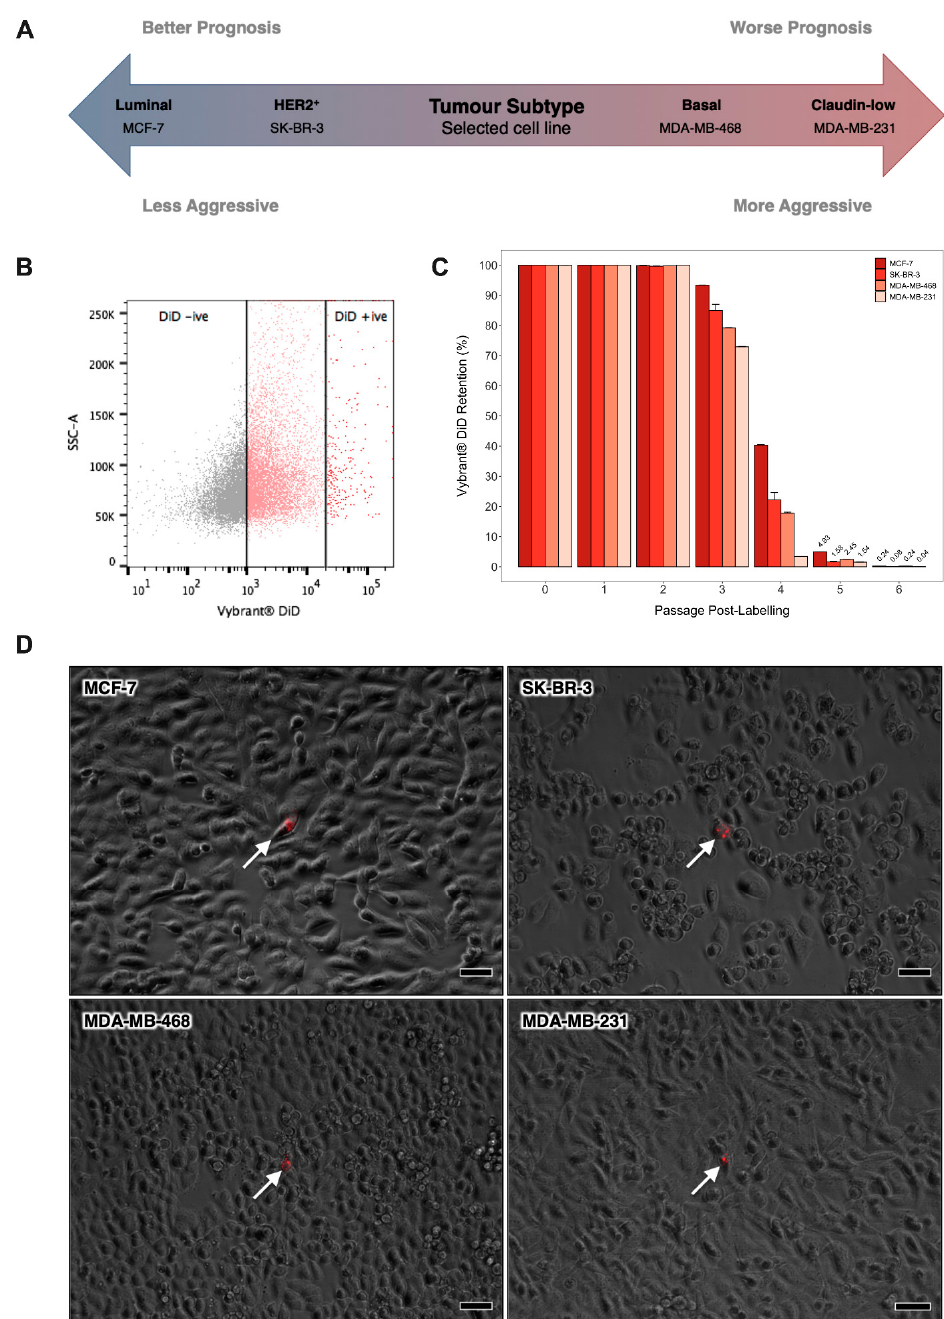
Figure 1. Identification of Quiescent Breast Cancer Cells by Lipophilic Dye Retention In vitro. ( A ) Schematic depicting the prognosis of the main breast tumour subtypes and the representative cell line selected to model each of these. ( B ) Cytofluorimetric dot plot illustrating the gating strategy for identification of Vybrant ® DiD retaining cells in adherent human breast cancer cell cultures after six passages of culture growth. Cytofluorimetric platforms were calibrated at the outset of each experiment using a Vybrant ® DiD negative (DiD − ) control sample and a Vybrant ® DiD positive (DiD+) control sample that had been freshly labelled with Vybrant ® DiD. ( C ) Proportion of label-retaining cells within adherent MCF-7, SK-BR-3, MDA-MB-468 and MDA-MB-231 cultures over six consecutive passages of culture growth as measured by flow cytometry. Data are expressed as mean ± SE (n = 3). ( D ) Phase-contrast and fluorescent image overlays of MCF-7, SK-BR-3, MDA-MB-468 and MDA-MB-231 cultures after 6 passages of culture growth post-staining with Vybrant ® DiD (scale bar = 50 μ m). White arrows indicate DiD+ cells (red).